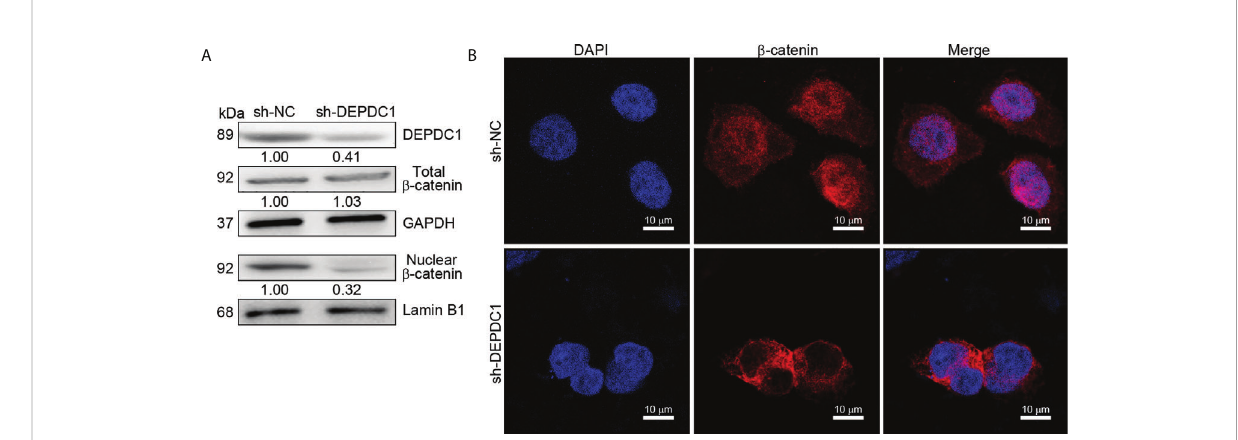
FIGURE 5 DEPDC1 downregulations in oral squamous cell carcinoma inhibit the Wnt/ b -catenin signaling pathway. (A) DEPDC1 has been tested for its effect on the Wnt/ b -catenin signaling pathway in SstainingstainingstainingCC-25 cells using a Western blot assessment. (B) The nuclear translocation of b -catenin was mediated by DEPDC1-immuno fl uorescence-stained b -catenin in sh-DEPDC1 treatment of SCC-25 cells. The data are presented as the mean±SD, and are representative of at least 3 independent